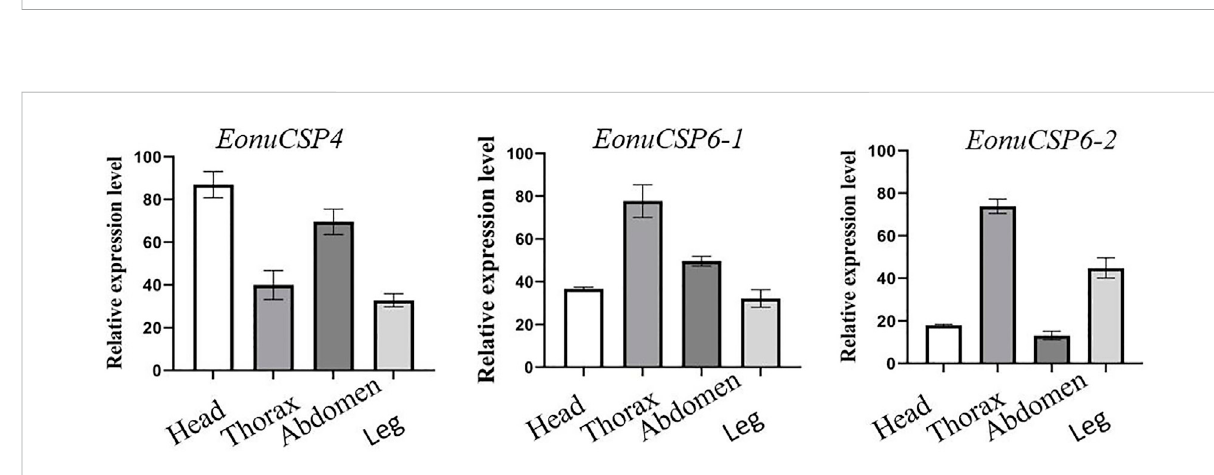
Three-dimensional structure of EonuCSPs. N-terminus, C-terminus, and helices are labeled. The six α -helices are labeled as α 1- α 6.